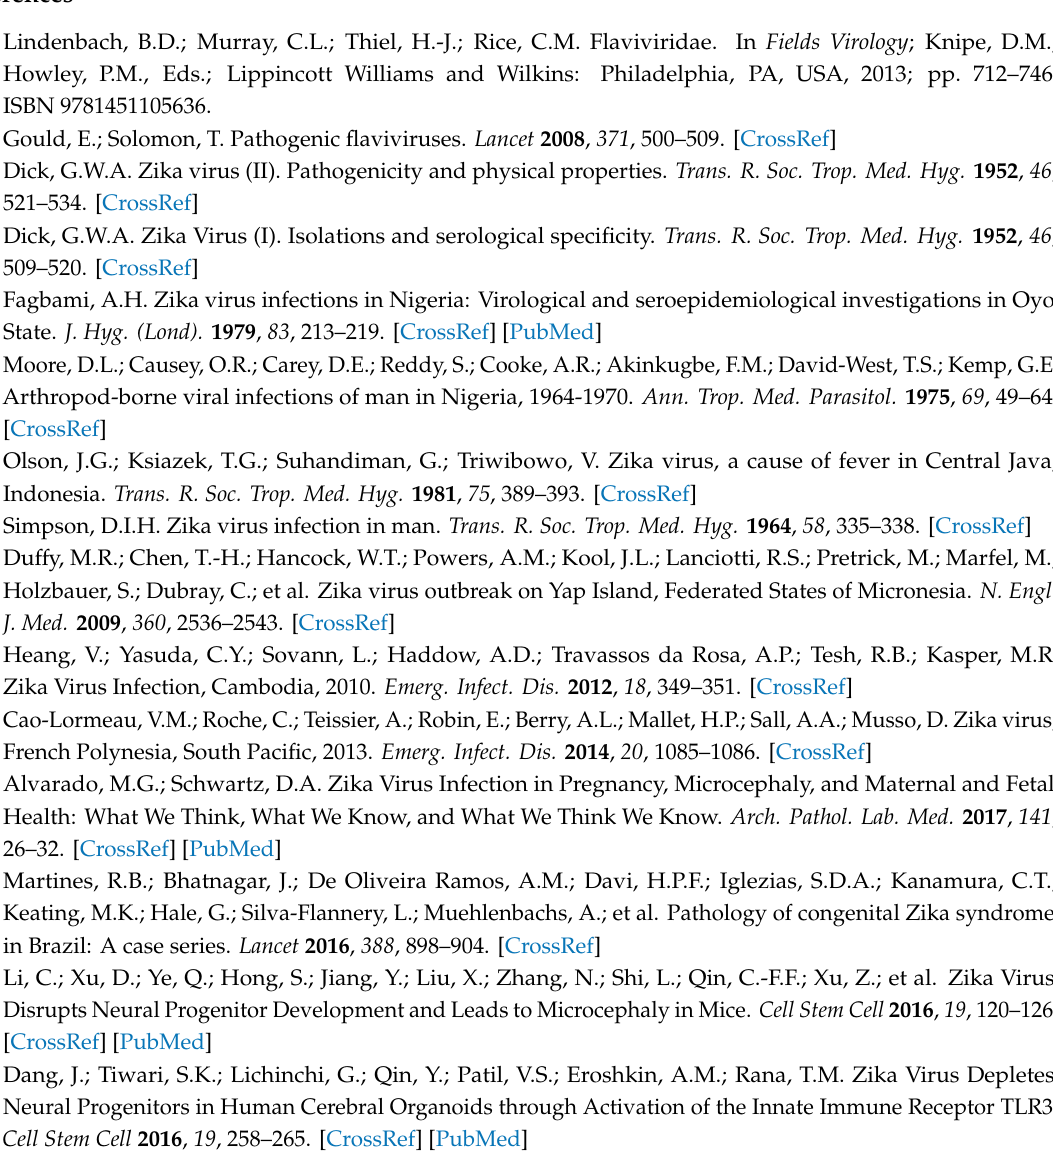
Schematic, gel analysis of RT-PCR products and Sashimi plots of eight validated alternatively spliced targets, and Figure S7: Correlation between RNA-seq- and RT-qPCR-derived PSI